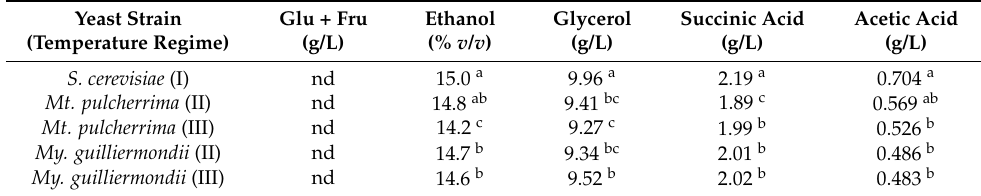
Table 1. Composition of finished wines fermented by S. cerevisiae alone (fermentation temperature regime I) or with selected non- Saccharomyces yeasts prior to inoculation of S. cerevisiae on day 3 (fermentation temperature regimes II or III).